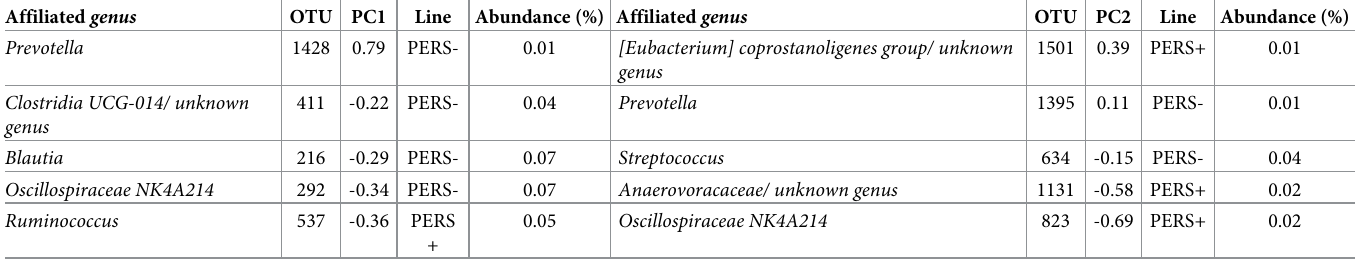
Table 2. Loading values per OTU with genus affiliation, associated genetic line and percentage of abundance, for the two first components from the milk persis- tency (PERS) line sparse partial least squares discriminant analysis. Affiliated genus OTU PC1 Line Abundance (%) Affiliated genus OTU PC2 Line Abundance (%) Prevotella 1428 0.79